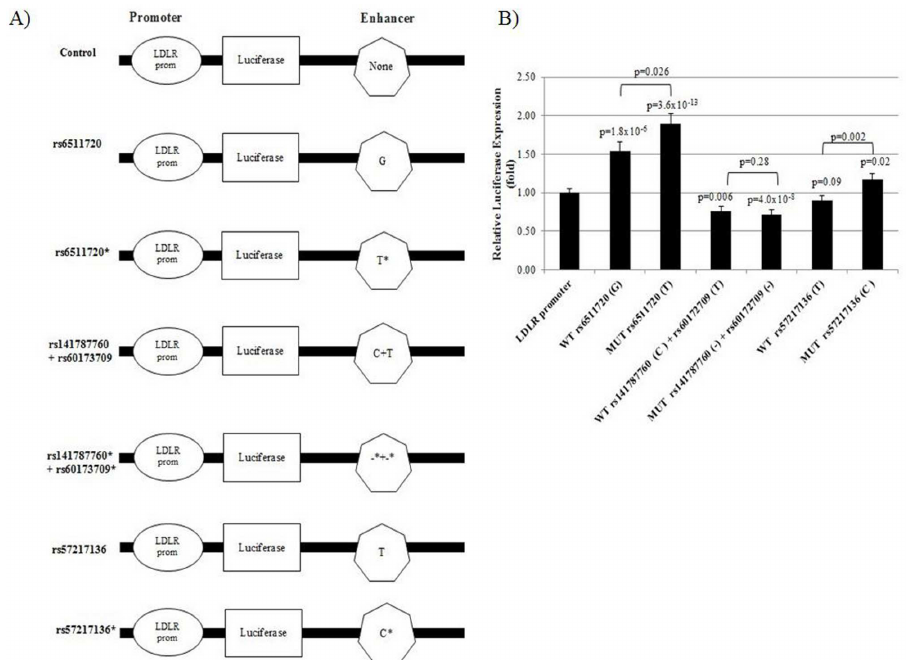
Fig 3. LDLR luciferase constructs and SNP luciferase activity in Huh7 cell line. A) Schematic presentation of LDLR - luciferase-construct (promoter only) and LDLR - luciferase-enhancer-constructs. The constructs were transfected into Huh7 cells. B) Results of luciferase reporter assays showingrelative expressionof LDLR-luciferase-enhancer constructs of LDLR SNPs relativeto the LDLR-luciferase (no enhancer) construct. (-) = deletionand ( * ) = minor